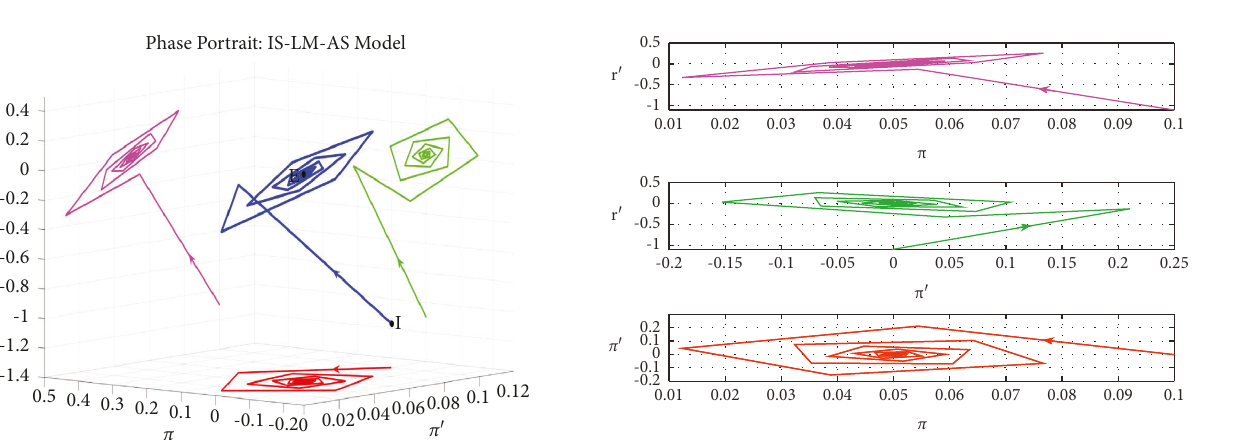
Figure 10: Three-dimensional phase portrait.